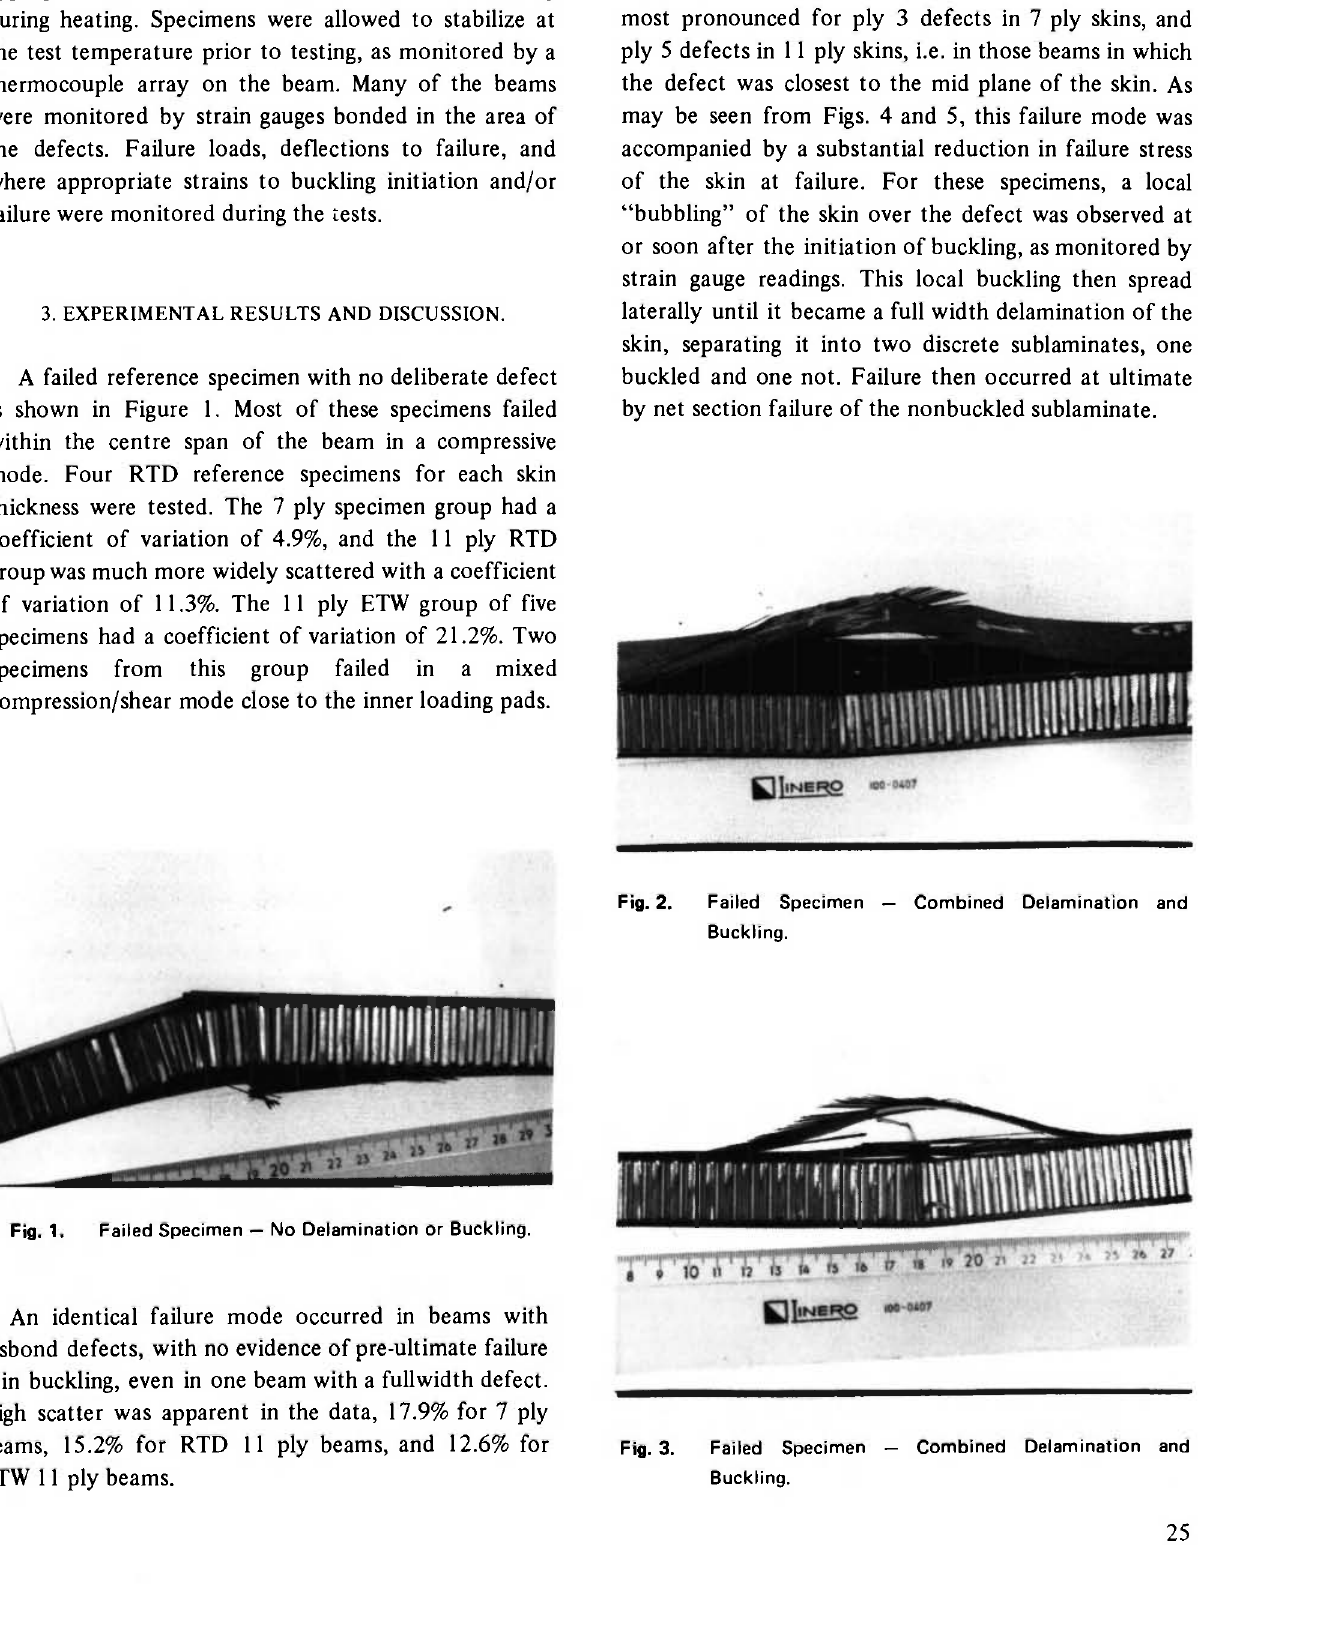
An identical failure mode occurred in beams with disbond defects, with no evidence of pre-ultimate failure skin buckling, even in one beam with a fullwidth defect. beams, 15.2% for RTD 11 ply beams, and 12.6% for ETW 11 ply beams.